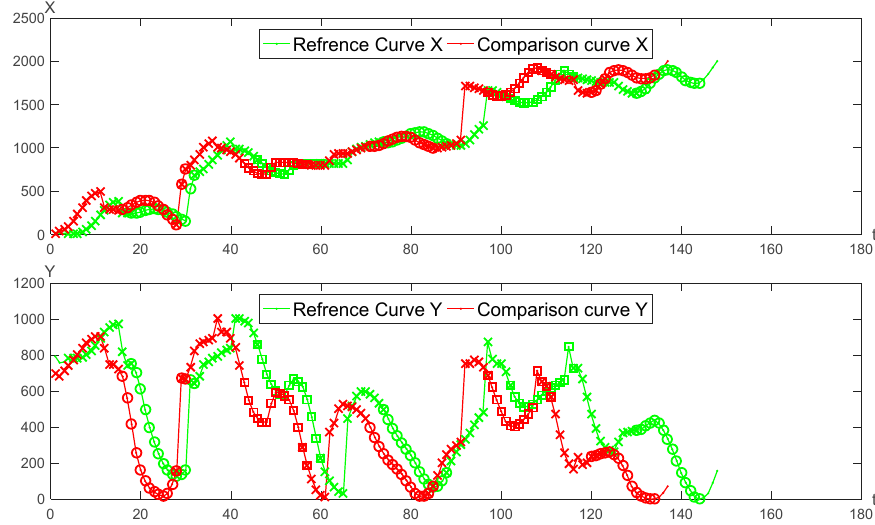
Figure 5. The matching results of two genuine signatures.